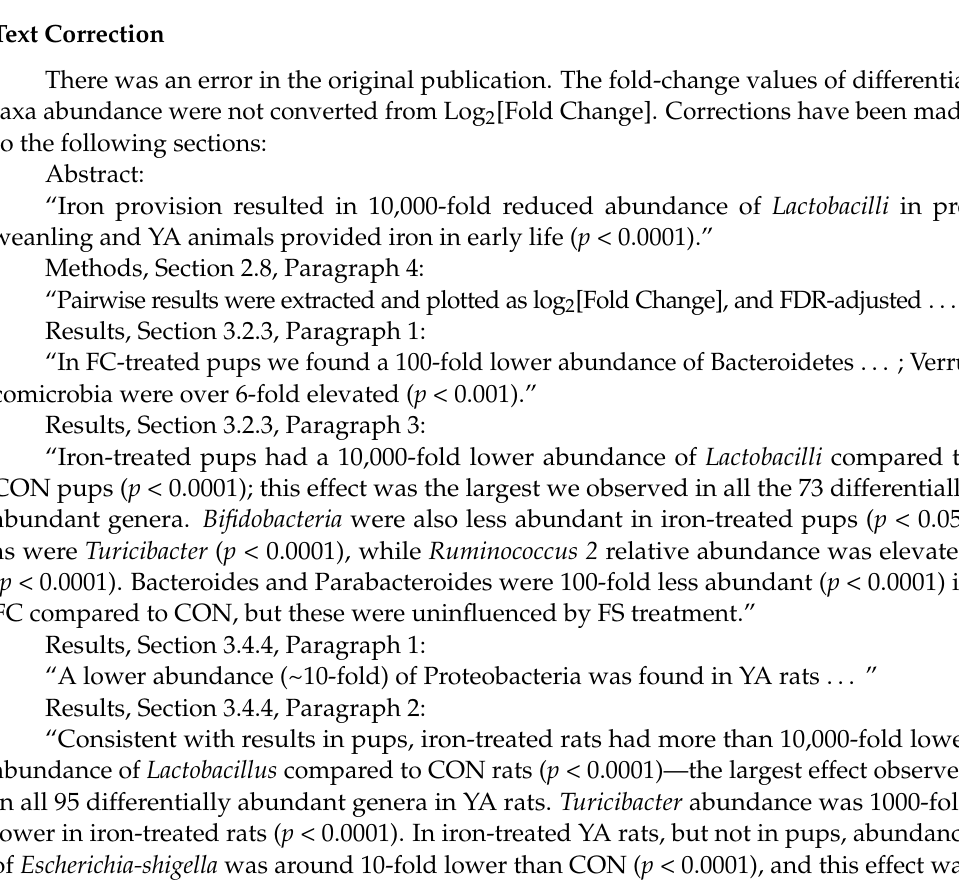
Figure S6. Differential abundance of cecal bacteria at the phylum ( left ) and genus level ( right ) in YA rats postnatally supplemented with FC vs. FS. All genera plotted are significantly different between iron groups. Differential abundance was determined using DESeq2 and FDR-adjusted p -values < 0.05 from pairwise group comparisons were considered significant. p -values are listed in Tables S7 and